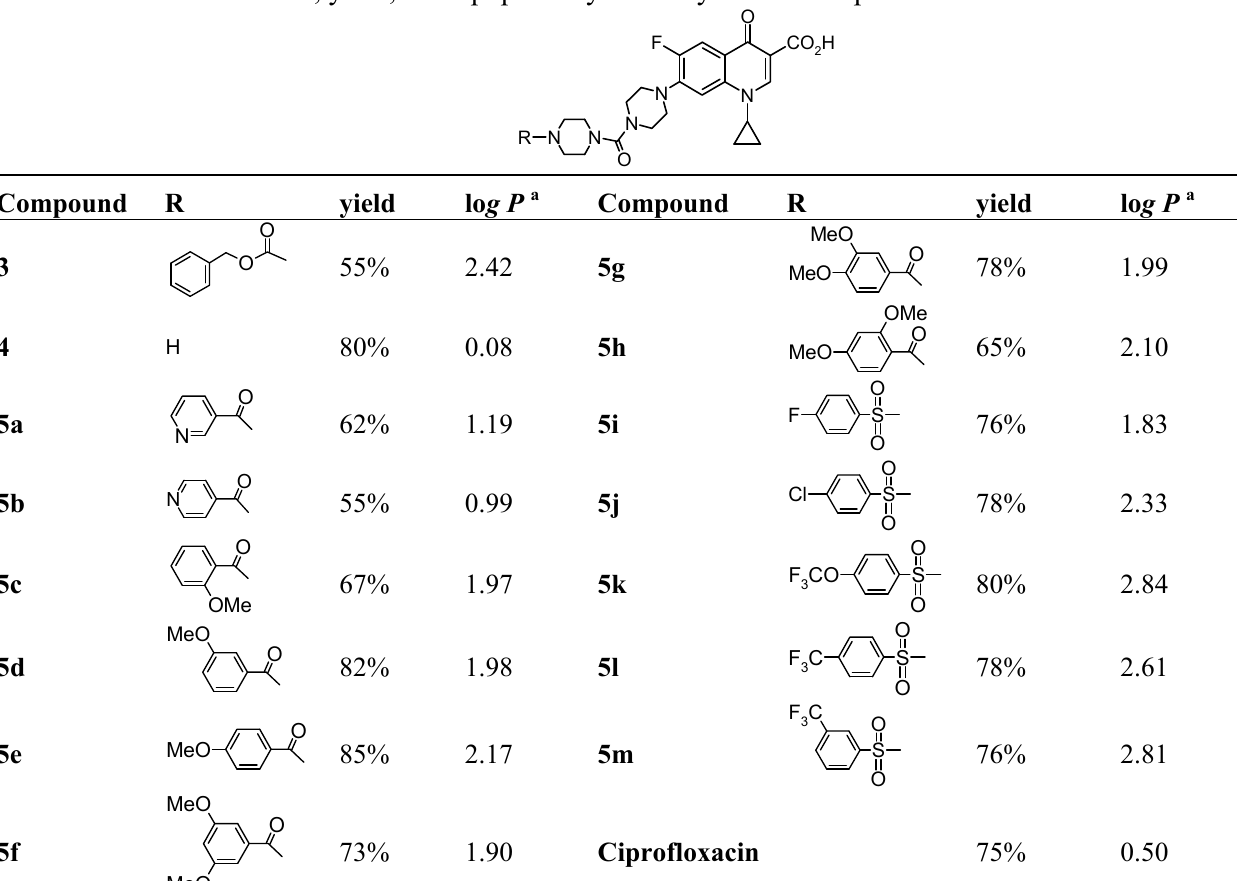
Table 1. Structure, yield, and lipophilicity of the synthesized ciprofloxacin derivatives.